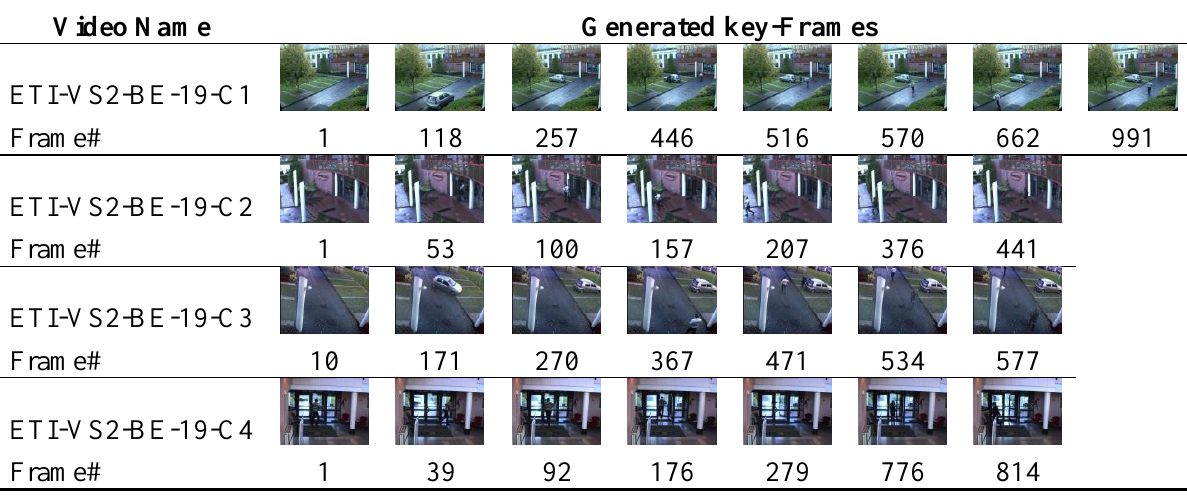
Table 6. Key-frames that are extracted at the VPH in our case study.